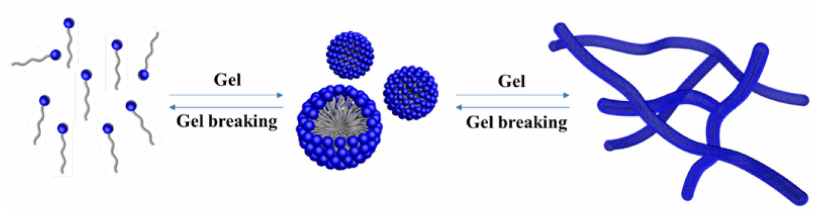
Figure 1. Mechanism of VES as fracturing fluid